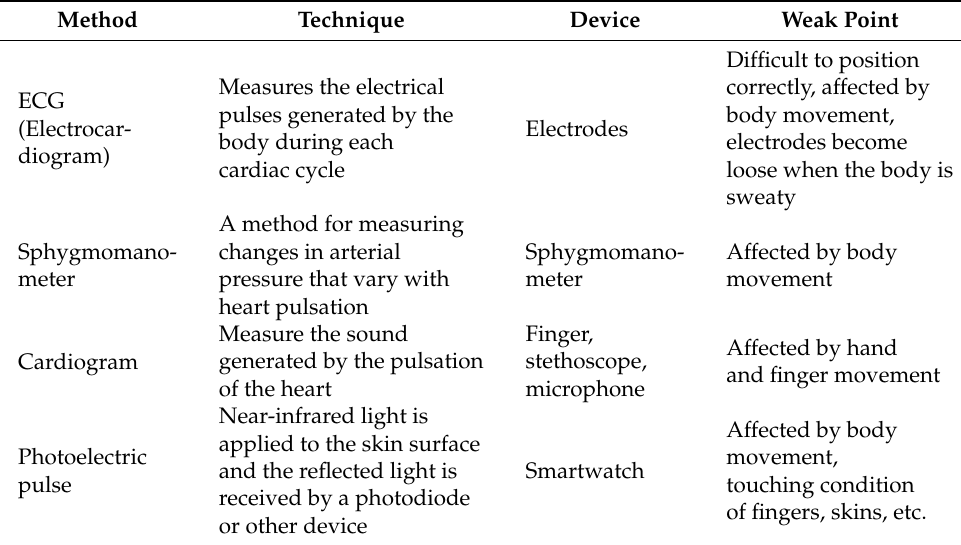
Table 1. Measuring heart rate methods and weak points of the general and traditional